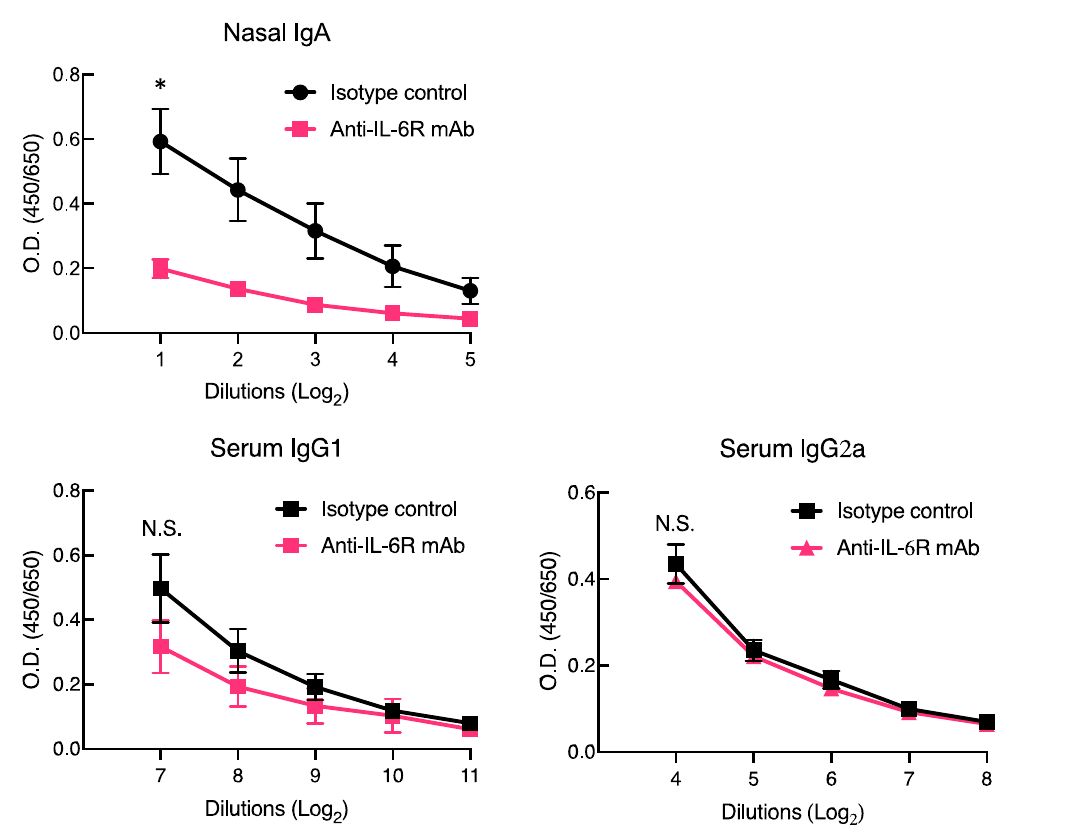
Figure 2. Inhibitory effect of anti-interleukin-6 receptor (IL-6R) blocking antibodies on CpG ODN- loaded cationic liposome-induced OVA-specific antibody responses. BALB/c mice were intraperito- neally treated with anti-IL-6R antibody (250 μ g/mouse) or the respective isotype control antibody (250 μ g/mouse) two days prior to the first immunization (day-2) and 1 h prior to each subsequent immunization (days 0 and 7). Mice were then immunized intranasally with OVA (5 μ g/mouse) in combination with CpG ODN-loaded cationic liposomes (10 μ g/mouse as CpG ODN) at a volume of 13 μ L twice weekly. One week after the last immunization, nasal washes and serum samples were collected. OVA-specific antibody responses were tested using ELISA. Isotype control, n = 4; anti-IL- 6R mAb, n = 4. Significant differences were evaluated using the Mann–Whitney U test. * p < 0.05.